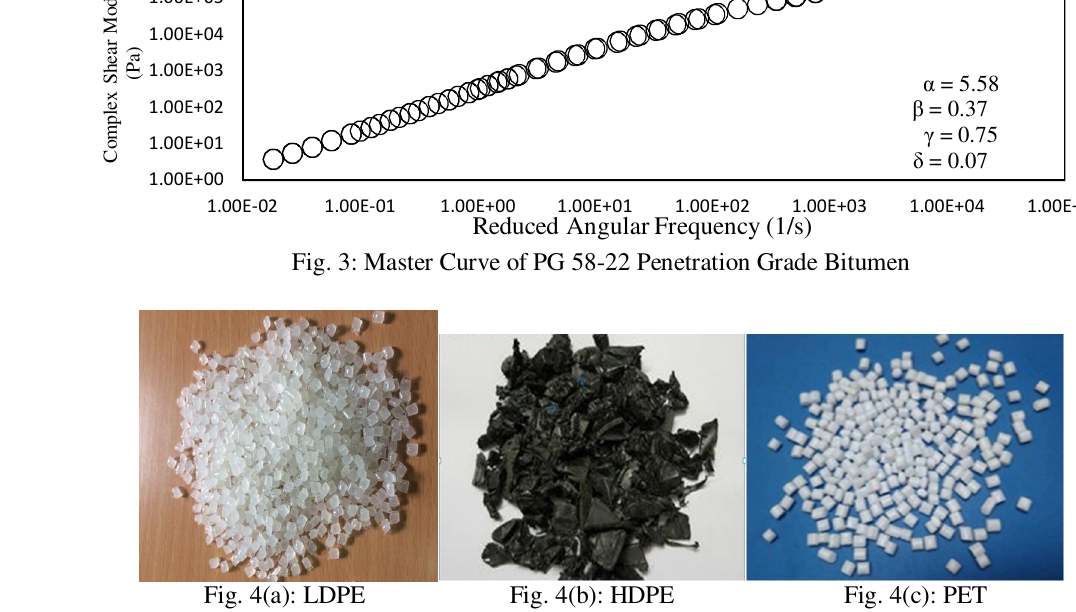
Fig. 4(a): LDPE Fig. 4(b): HDPE Fig. 4(c):